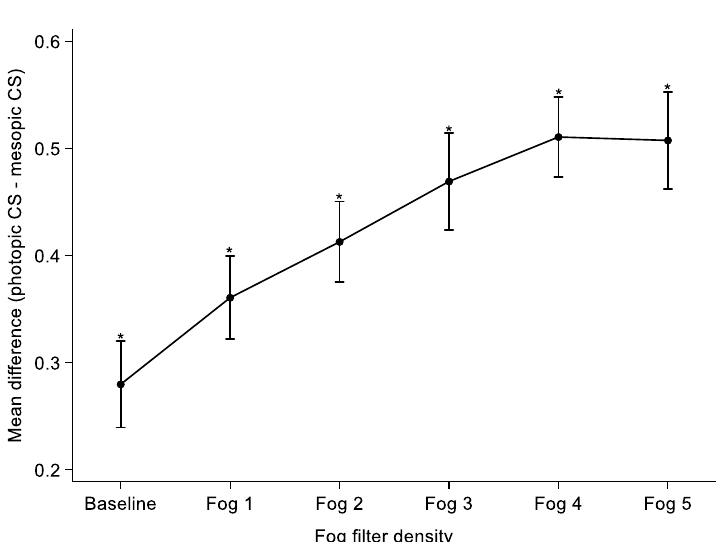
Figure 4. Mean difference between photopic and mesopic CS at baseline and under different Fog filter conditions as measured with the Pelli-Robson chart. Error bars are 95% confidence interval of the mean difference. * = p < 0.05 representing significant difference between mean photopic and mesopic CS at baseline and when media opacity was simulated with all Fog